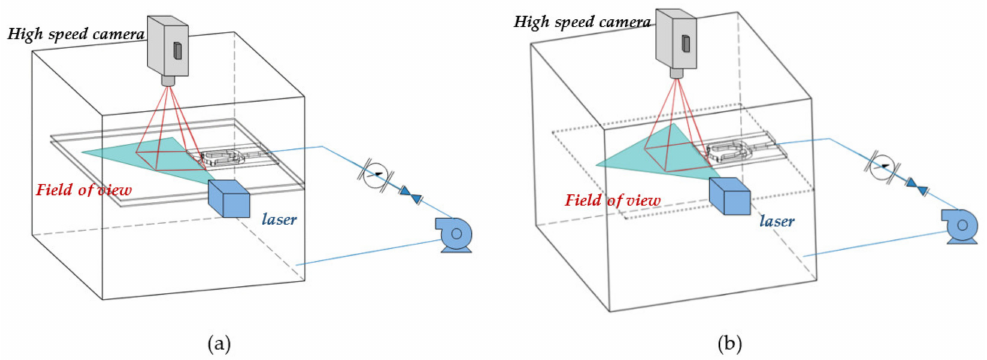
Figure 4. Experimental setup for ( a ) fully confined and ( b ) free external